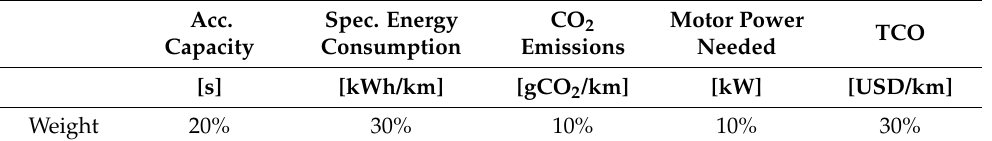
Table 2. Relevant performance